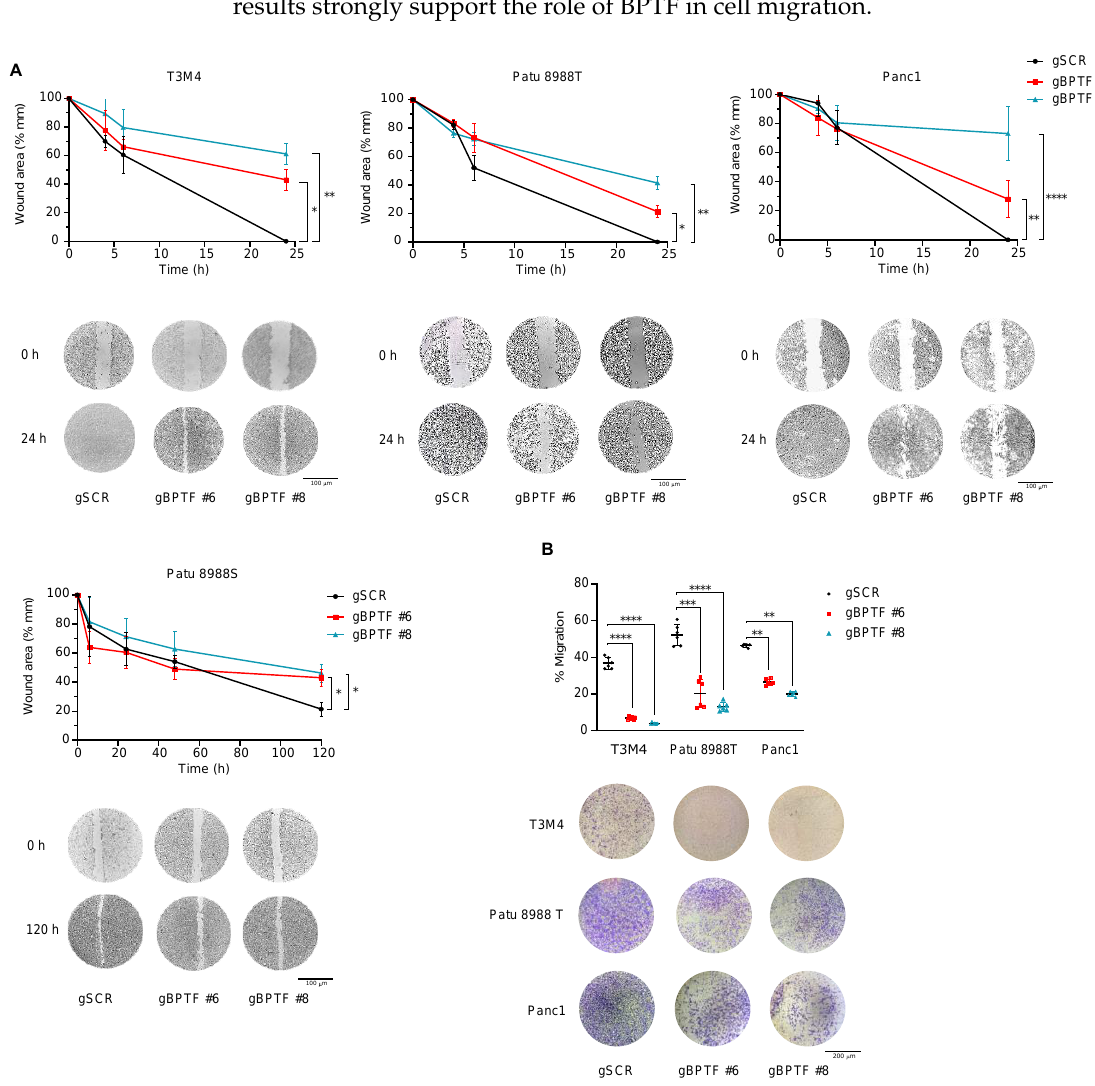
Figure 3. BPTF-silencing by CRISPRi impairs tumour migration in human PDA cell lines. ( A ) Wound-healing assay of BPTF-interfered cells (gBPTF #6 and gBPTF #8) compared to non-targeted (gSCR) for 4, 6, and 24 h in a panel of human PDA cell lines; n = 3. ( B ) Transwell assay of BPTF-interfered cells (gBPTF #6 and gBPTF #8) compared to non-targeted (gSCR) for 24 h in a panel of PDA cell lines; n = 6. Significance was considered for * p < 0.05, ** p < 0.01, *** p < 0.005, and **** p < 0.001.